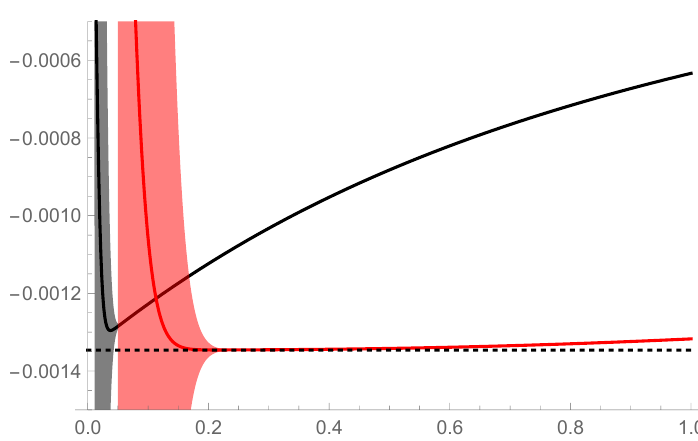
Figure 9 . Plot of the function f ( α ) in (4.57) for the O ( N ) non-linear sigma model with N = 6 (black), as well as its respective second Richardson transforms (red). The dashed line is the predicted asymptotic value. The shaded areas correspond to error estimates from the convergence of the Padé